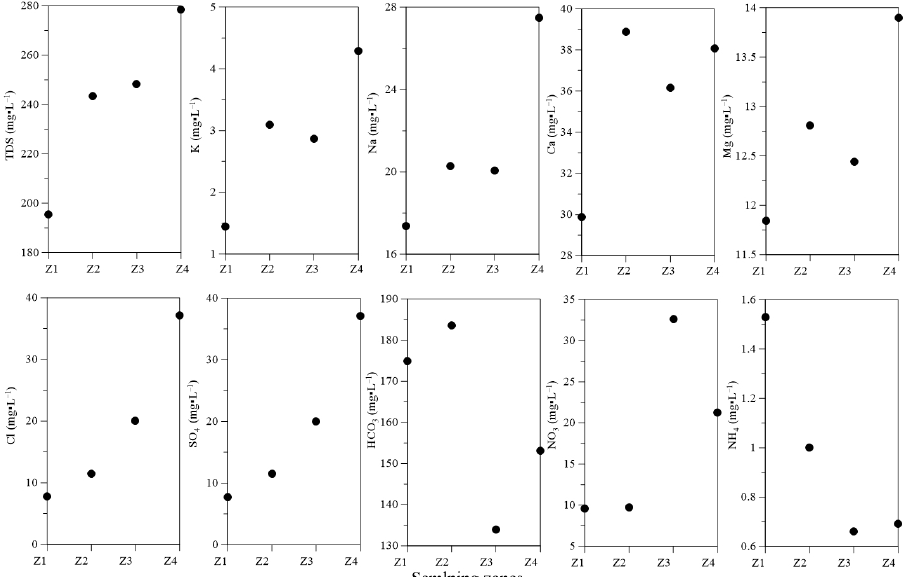
Figure 2. Concentration of chemical parameters in four zones.